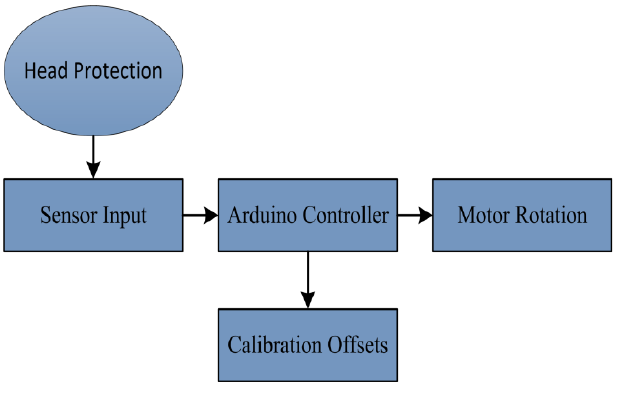
Figure 6. Block diagram of the head rotation